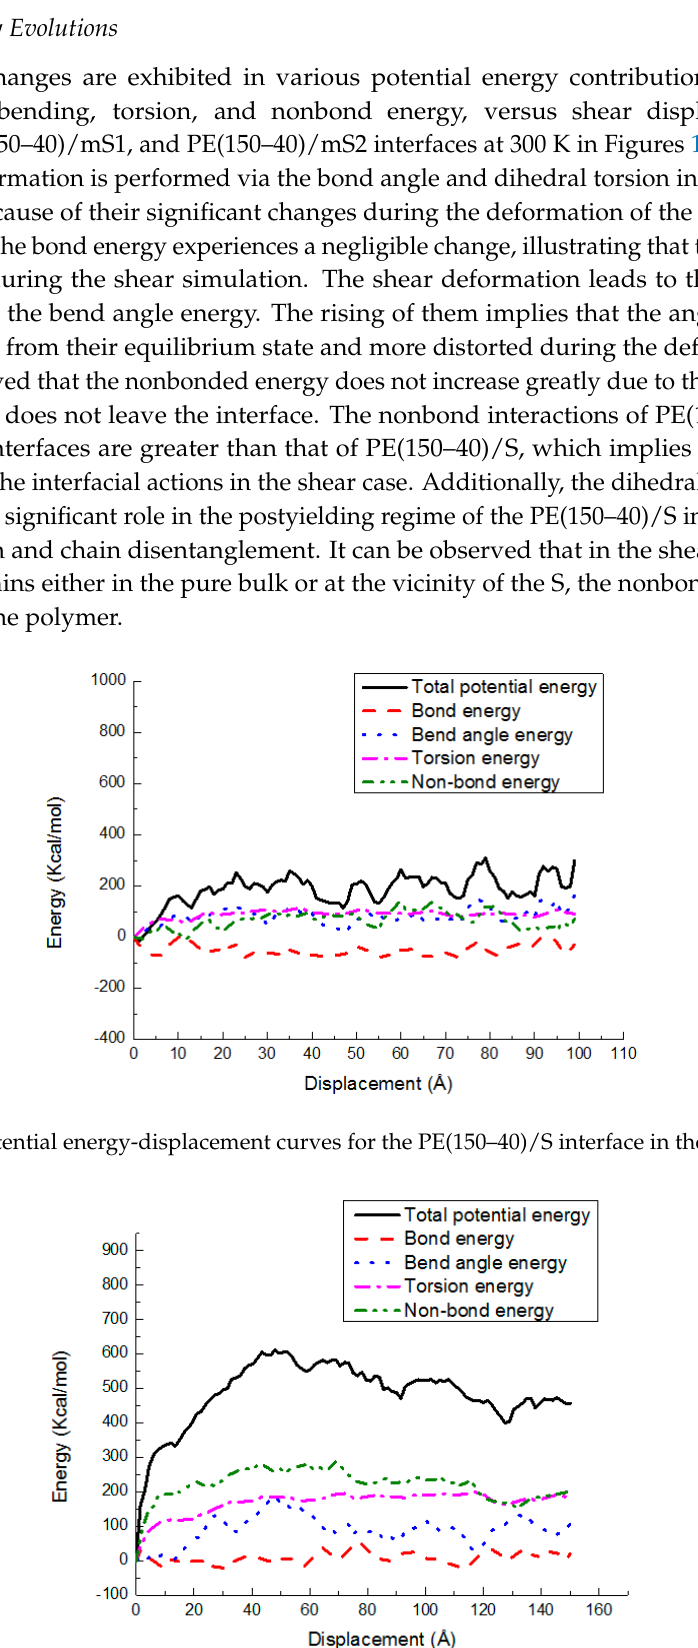
Figure 14. Potential energy-displacement curves for the PE(150 – 40)/mS1 interface in the shear case. Please change the format like -40 to − 400(use minus sign)